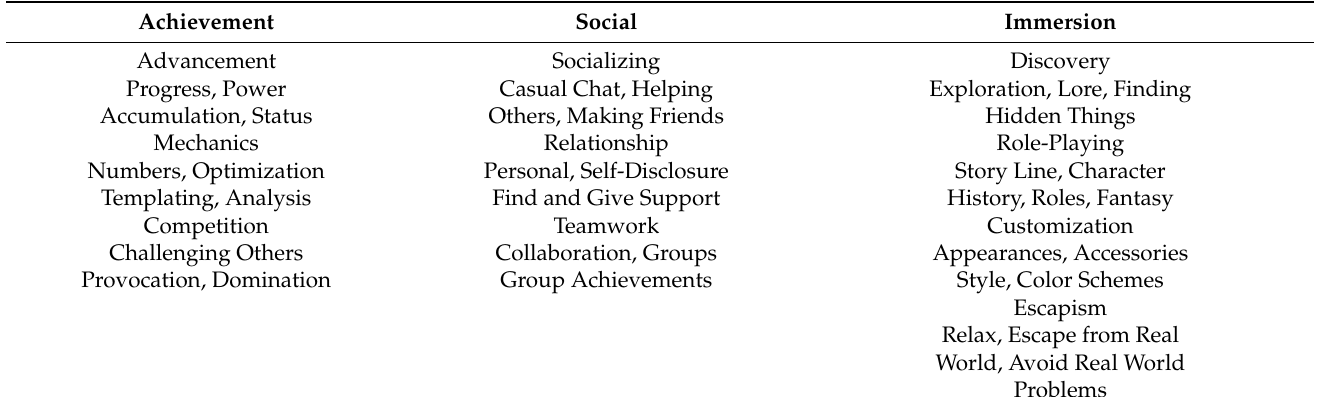
Table 2. Yee’s player motivation categories (Source: Yee (2006)